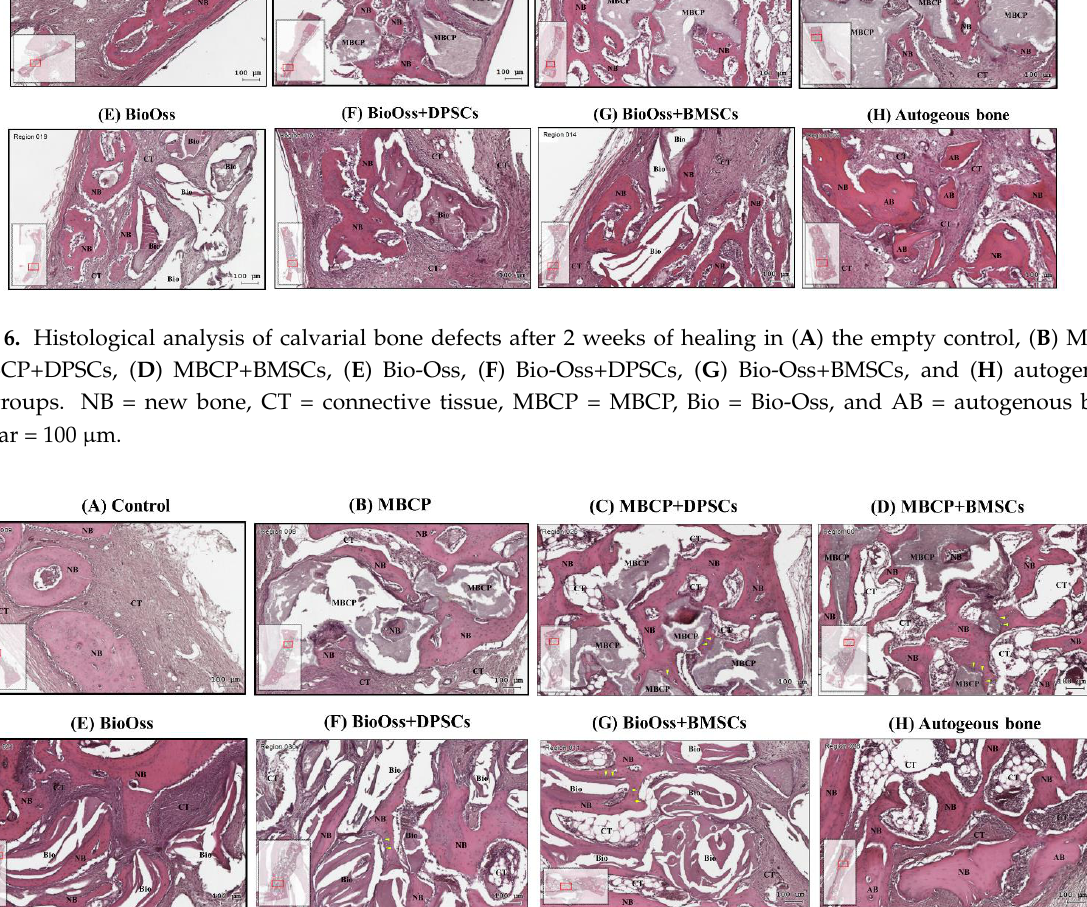
Figure 8. Histological analysis of calvarial bone defects after 8 weeks of healing in ( A ) the empty control, ( B ) MBCP, ( C ) MBCP+DPSCs, ( D ) MBCP+BMSCs, ( E ) Bio-Oss, ( F ) Bio-Oss+DPSCs, ( G ) Bio-Oss+BMSCs, and ( H ) autogenous bone groups. NB = new bone, CT = connective tissue, MBCP = MBCP, Bio = Bio-Oss, AB = autogenous bone, and BM = bone marrow. Scale bar = 100 μm. Overall, the histological and histomorphometric results indicated a higher new bone formation capacity in the MBCP+DPSC, MBCP+BMSC, Bio-Oss+DPSC, Bio-Oss+BMSC, and autogenous bone groups than in the empty control, MBCP-only, and Bio-Oss-only groups at week 2 and week 4. However, comparable results were observed among the MBCP-only, MBCP+DPSC, MBCP+BMSC, Bio-Oss-only, Bio-Oss+DPSC, and Bio- Oss+BMSC groups after 8 weeks of healing (Figures 6–9).